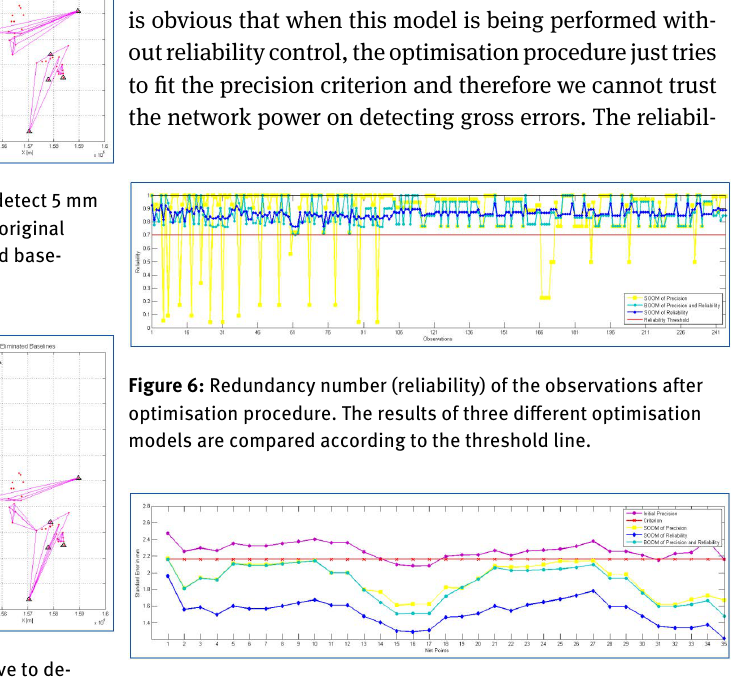
Figure 7: Precision of the net points after optimisation based on different models are plotted. The standard error of points before optimisation is also drawn for better